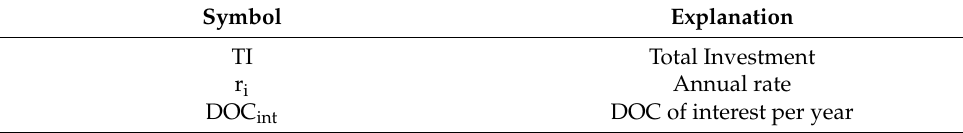
Table 2. Interest cost symbols explanation.